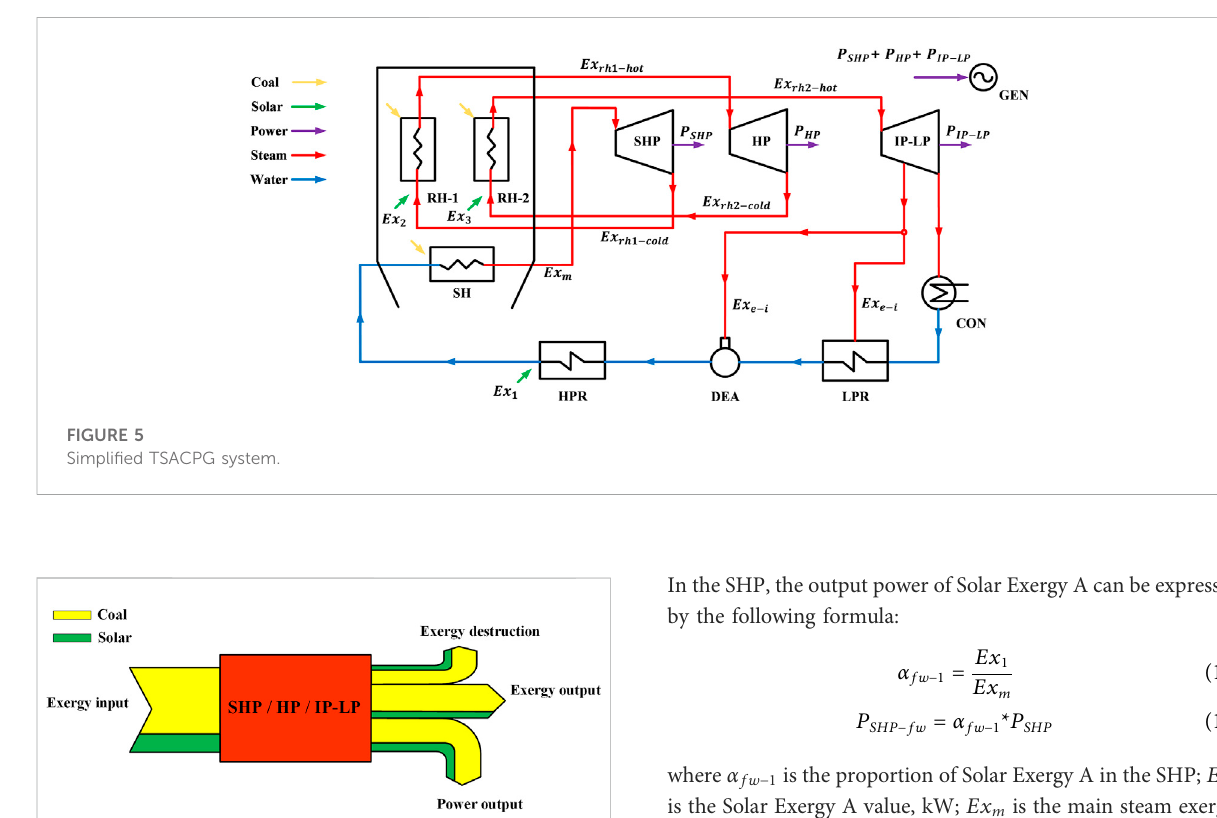
FIGURE 6 Illustration of exergy destruction distribution in the turbine